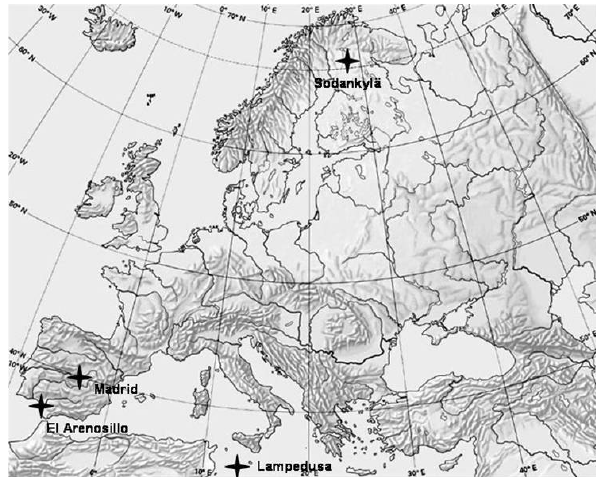
Fig. 1. Geographic map of the measurement